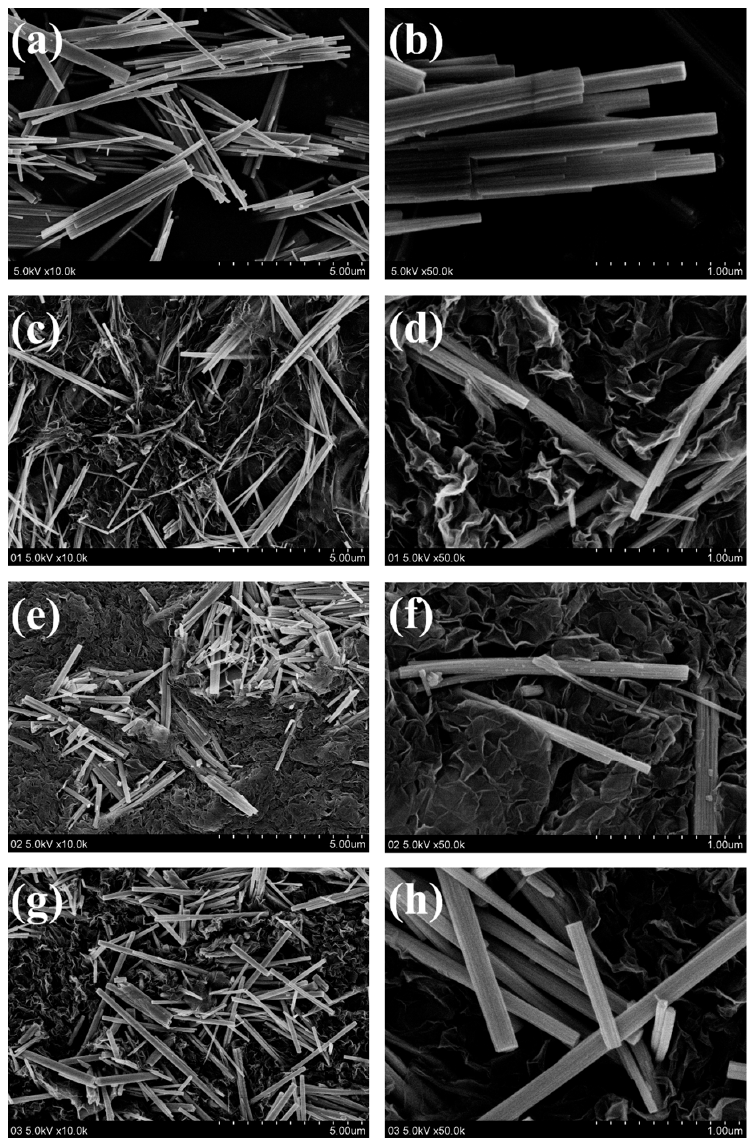
Figure 3. SEM images of: ( a , b ) WO 3 ; ( c , d ) WO 3 /GR-0.1; ( e , f ) WO 3 /GR-0.5; and ( g , h ) WO 3 /GR-1.